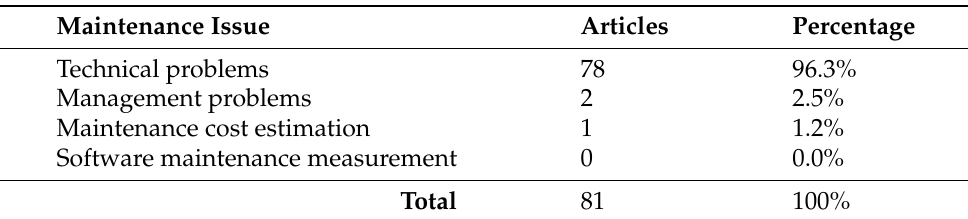
Table 10. Details of studies and maintenance issues studied.